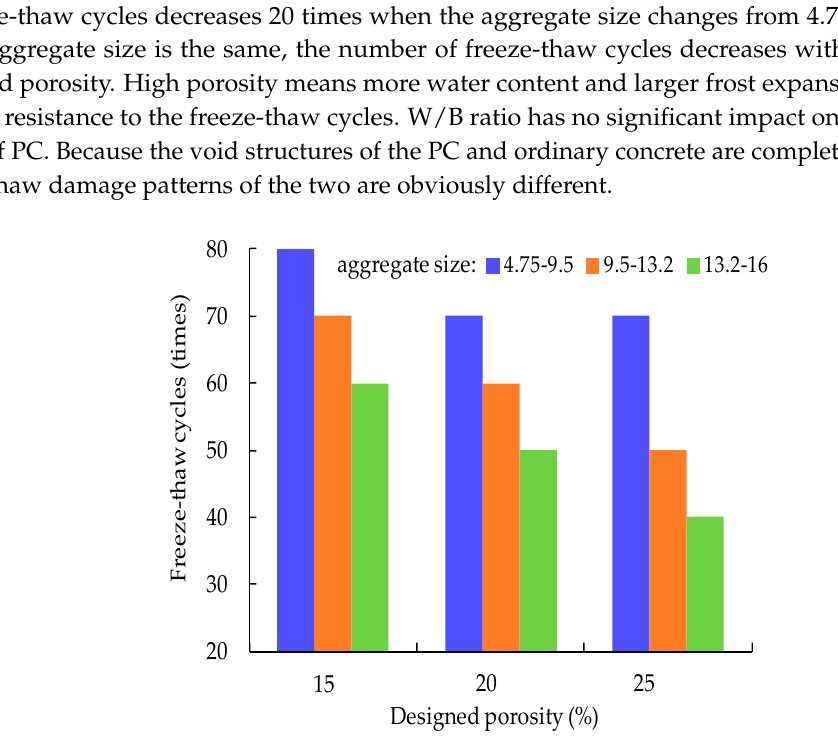
Figure 13. Relationship between freeze-thaw cycles, designed porosity and aggregate size.